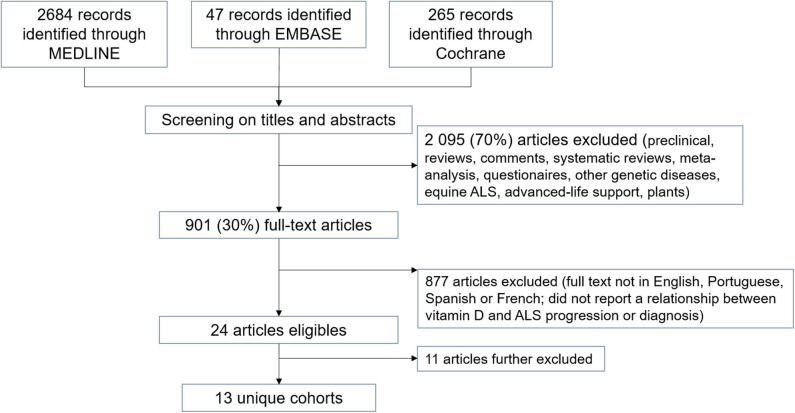
Flow diagram of literature search results for our systematic review.